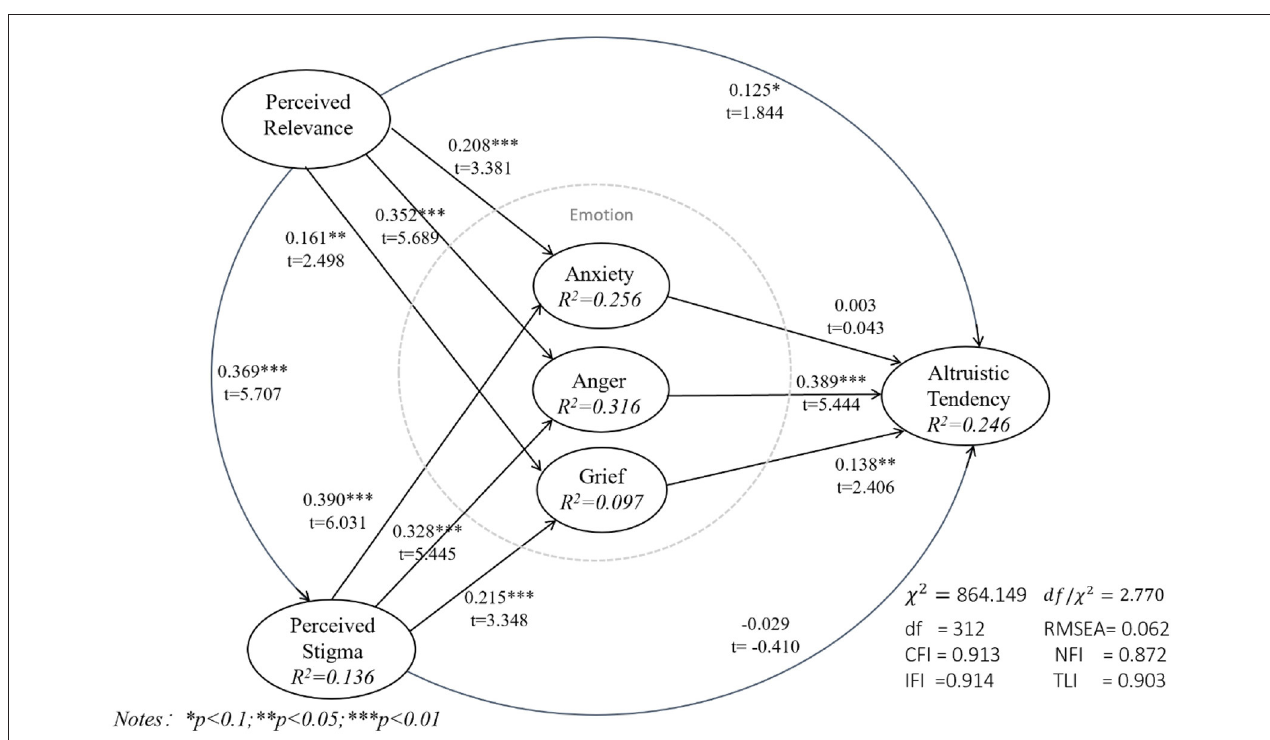
FIGURE 3 | Results of the research